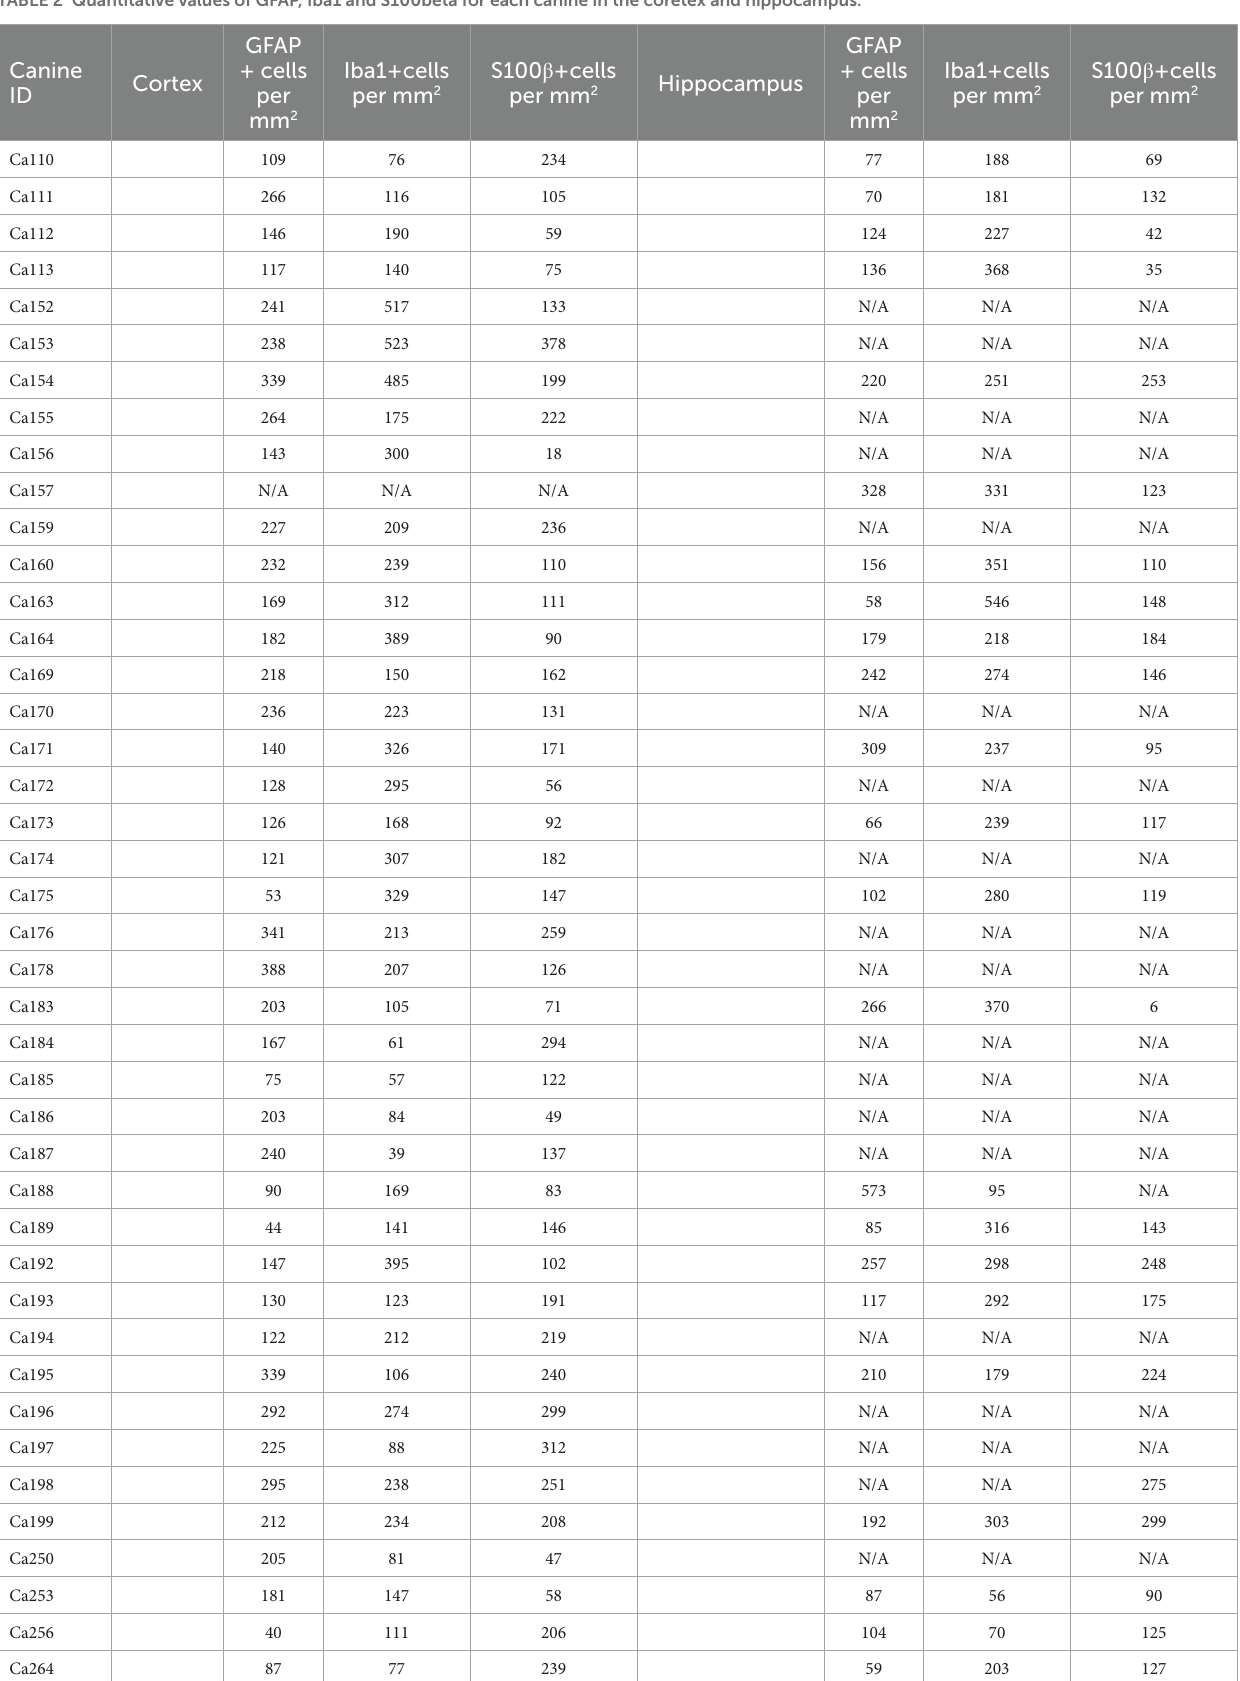
TABLE 2 Quantitative values of GFAP, Iba1 and S100beta for each canine in the coretex and hippocampus.